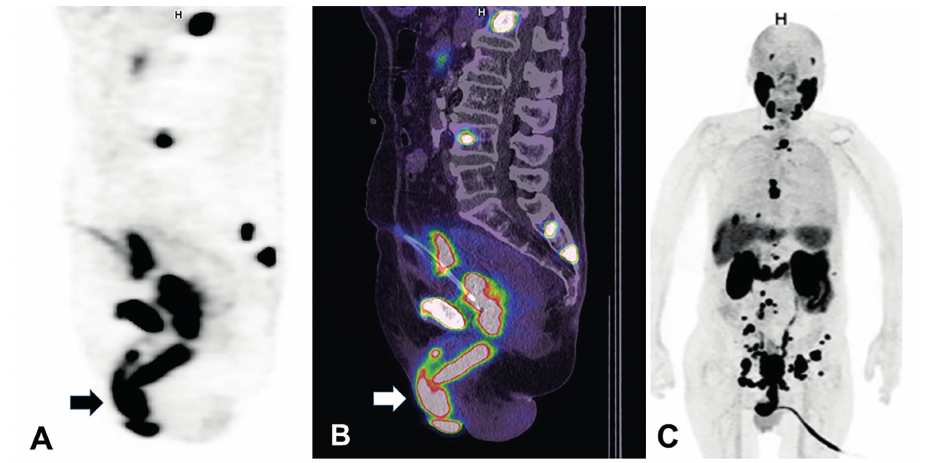
Figure 5 - Penile metastases.